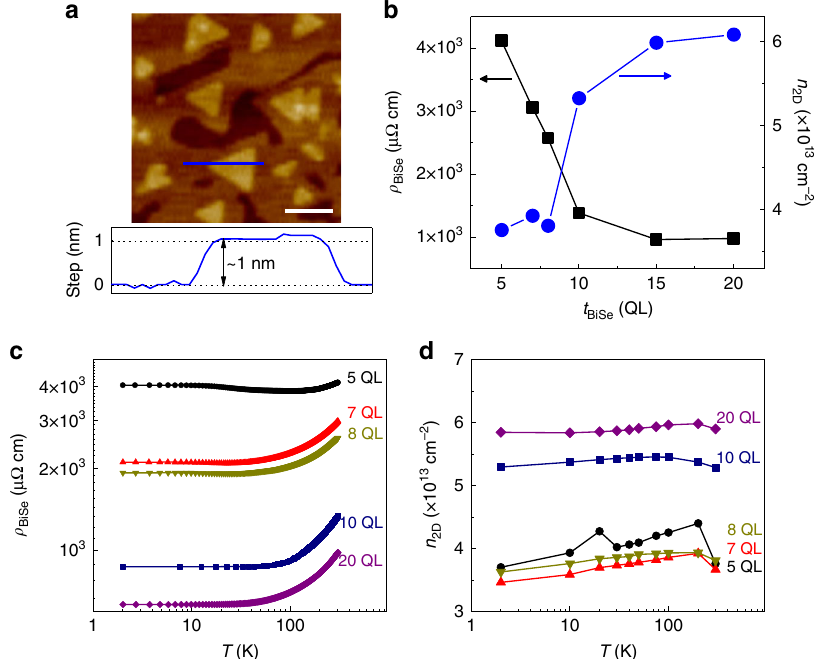
Fig. 1 Bi 2 Se 3 fi lm properties. a AFM image of a 10-QL Bi 2 Se 3 fi lm with a roughness of ~0.5 nm. 1 QL ( ≈ 1 nm) step of crystal terrace along the blue line is clearly observed. The white scale bar is 100 nm. b Bi 2 Se 3 thickness-dependent resistivity, ρ BiSe , and sheet carrier concentration, n 2D , in Bi 2 Se 3 at room temperature. c , d ρ BiSe and n 2D as a function of temperature for Bi 2 Se 3 fi lms with different thicknesses,